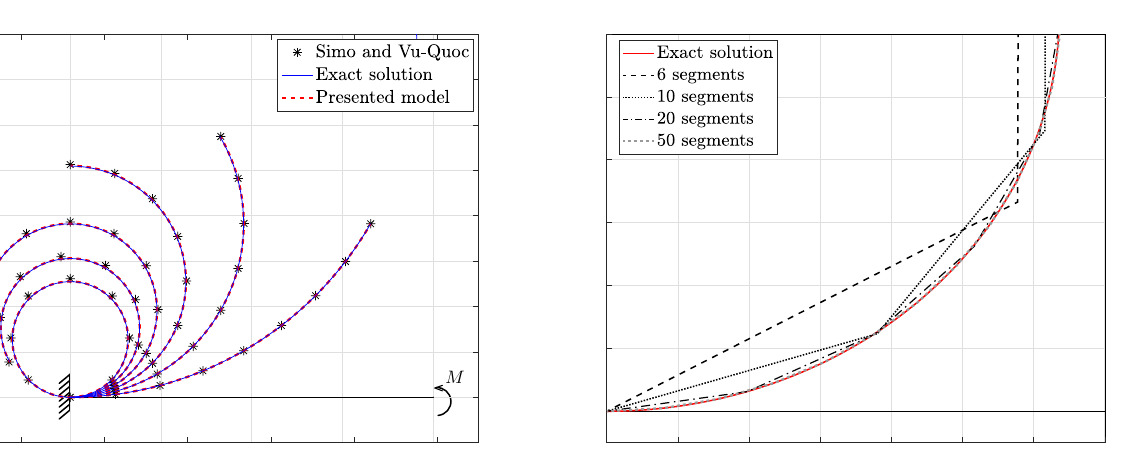
Figure 3. Pure bending of a cantilever beam sub- jected to end moment.